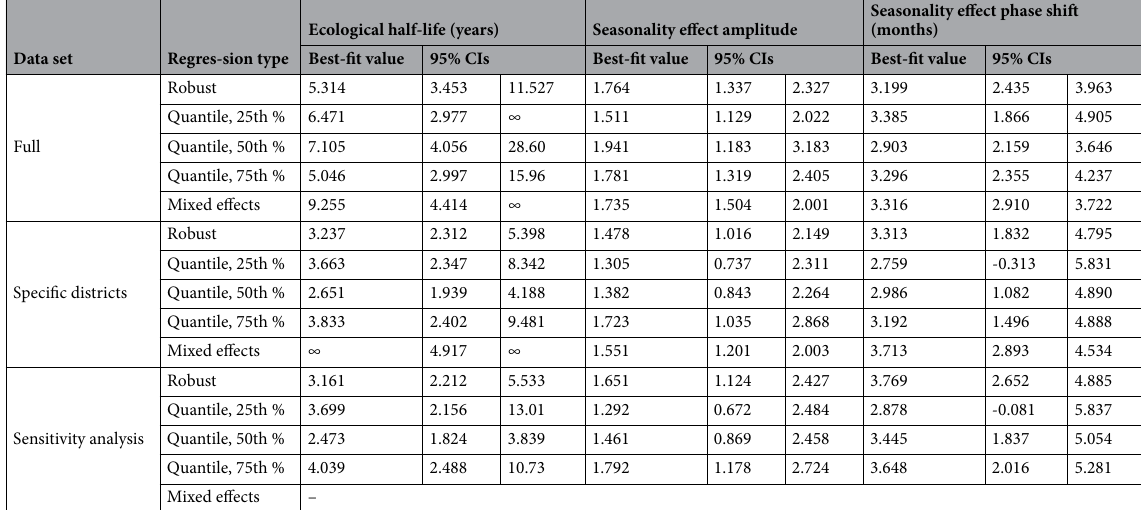
Table 6. Summary metrics for robust, quantile and mixed-effects fits of our model (Eq. 1A, 1B) to Asian black bear data. During sensitivity analysis, mixed effects models did not converge well due to limited data (only 163 samples), so no corresponding parameter values are